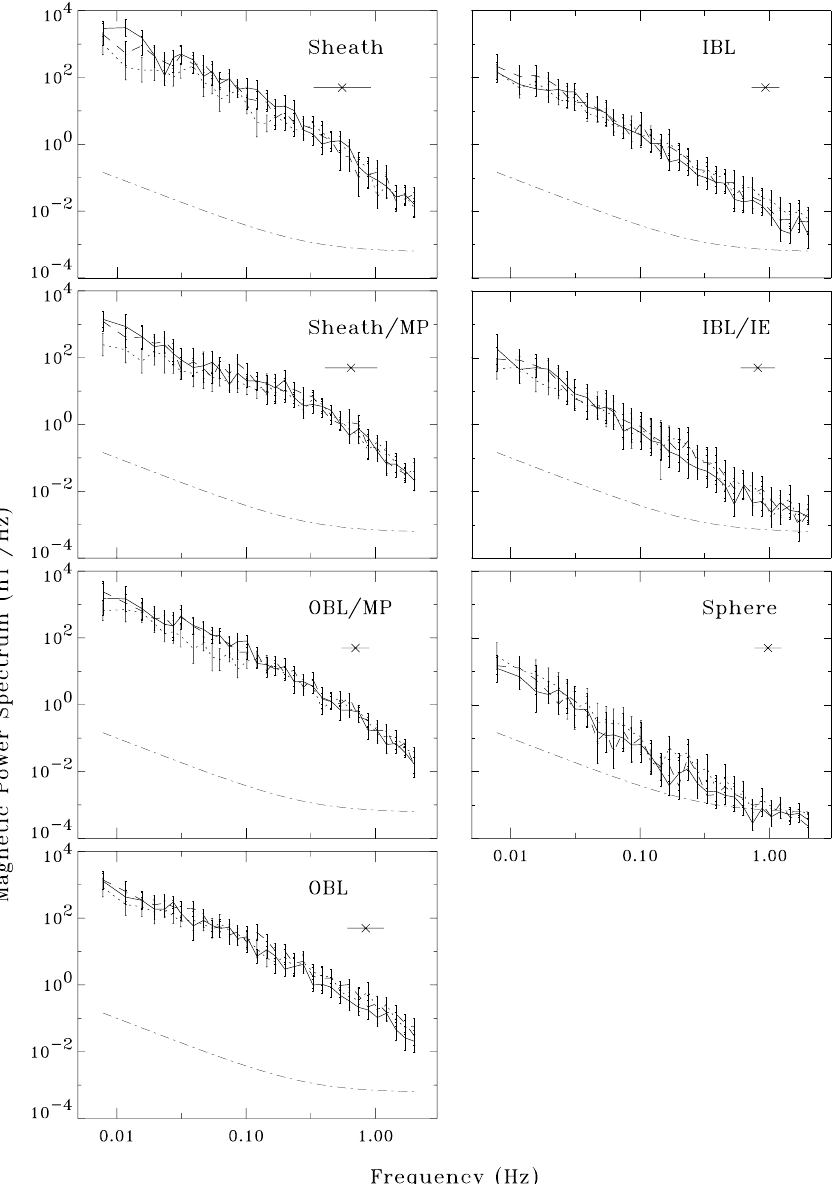
Fig. 11. Spectra of magnetic fluctua- tions in the vicinity of the boundary layer averaged over the crossings of the data set. Each diagram displays power spectra of compressional fluctuations, S B (solid line), transverse fluctuations k normal to the magnetopause, S B n ⊥ (dotted line), and transverse fluctua- tions tangential to the magnetopause, S B (dashed line), in a normalized t ⊥ time interval. The spectra are averaged within the interval of one event and then again averaged over all events. On the left side, we see from top to bottom spectra in the magnetosheath ( − 1 < ˆ t < − 0 . 5 ), in the magnetosheath close to the magnetopause ( − 0 . 5 < ˆ t < 0 ), in the sheathward half of the OBL ( 0 < ˆ t < 0 . 5 ), and in the earthward half of the OBL ( 0 . 5 < ˆ t < 1 ). On the right side, we see from top to bottom spec- tra in the sheathward half of the IBL ( 0 < ˘ t < 0 . 5 ), in the earthward half of the IBL ( 0 . 5 < ˘ t < 1 ), and in the magnetosphere ( 1 < ˘ t < 1 . 5 ). Verti- cal error bars indicate the standard de- viation of the average of S B , S B , n ⊥ k and S B . The dash-dotted line gives t ⊥ the noise level. Crosses with horizontal error bars give the average and standard deviation ( ± σ ) of the proton gyrofre-